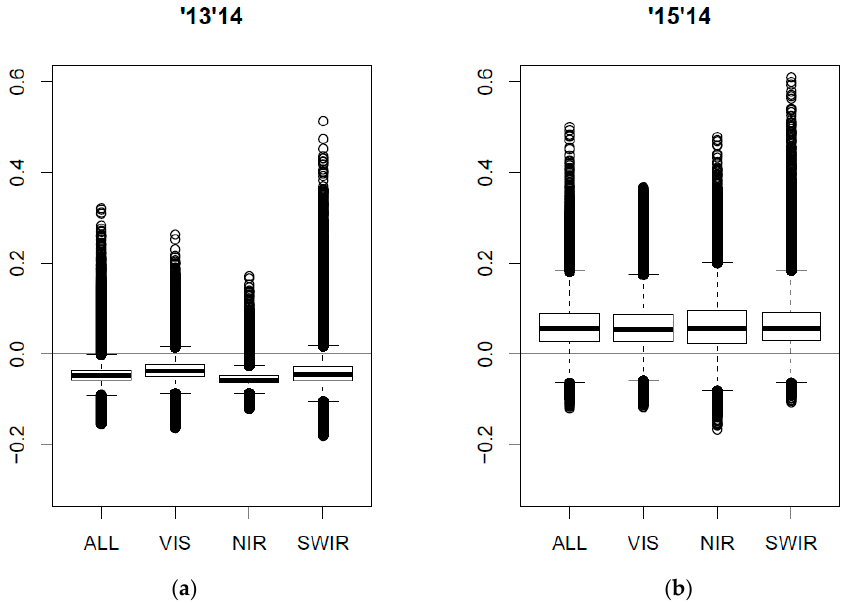
Figure 5. Distribution of the SMPE values for: ( a ) ‘13’14; and ( b ) ‘15’14. Distribution is given for the full spectra (ALL: 450–2200 nm), and for the specific ranges of the spectra (VIS: visible spectrum 450–700 nm, NIR: near-infrared spectrum 700–1400 nm, and SWIR: short-wave infrared 1400–2200